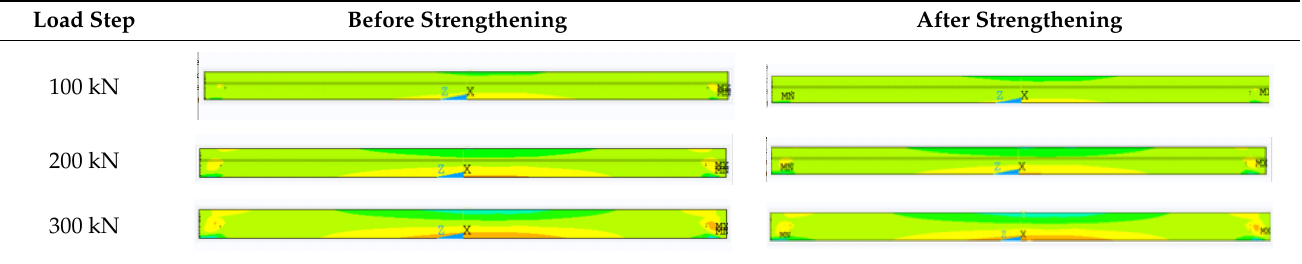
Table 5. Stress contours of the 1# girder under the symmetrical loading condition.